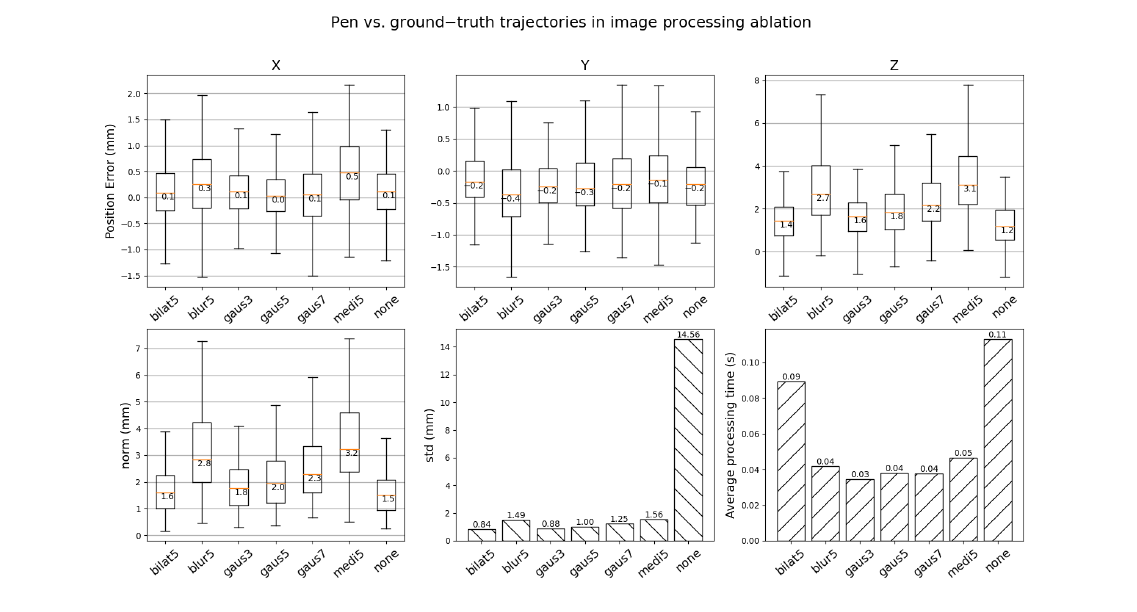
Figure 18. Image processing ablation. The position error between the pen tip and the ChArUco board origin is verified with multiple image filtering algorithms including bilateral ( bilat 5), normalized box ( blur 5), Gaussian ( gaus 3, gaus 5, gaus 7), median ( medi 5), and without such blurring ( none ). The first row depicts the average error per-axis using the box plots without outliers, whereas the second row is reserved for the average norm error, i.e., all axes, standard deviation, and processing